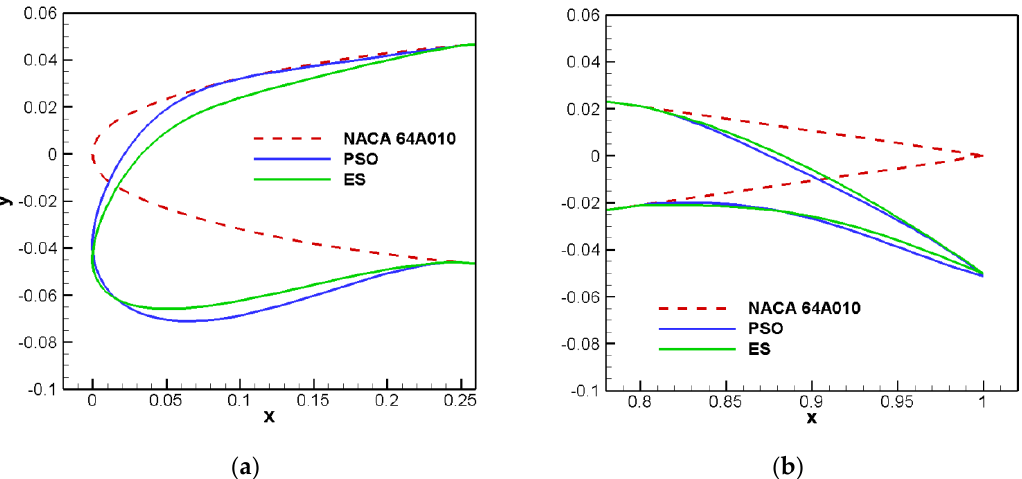
Figure 5. Comparison of the morphing achieved using the PSO (four generations) and ES (eight generations) algorithms ( a ) LE region and ( b ) TE region.